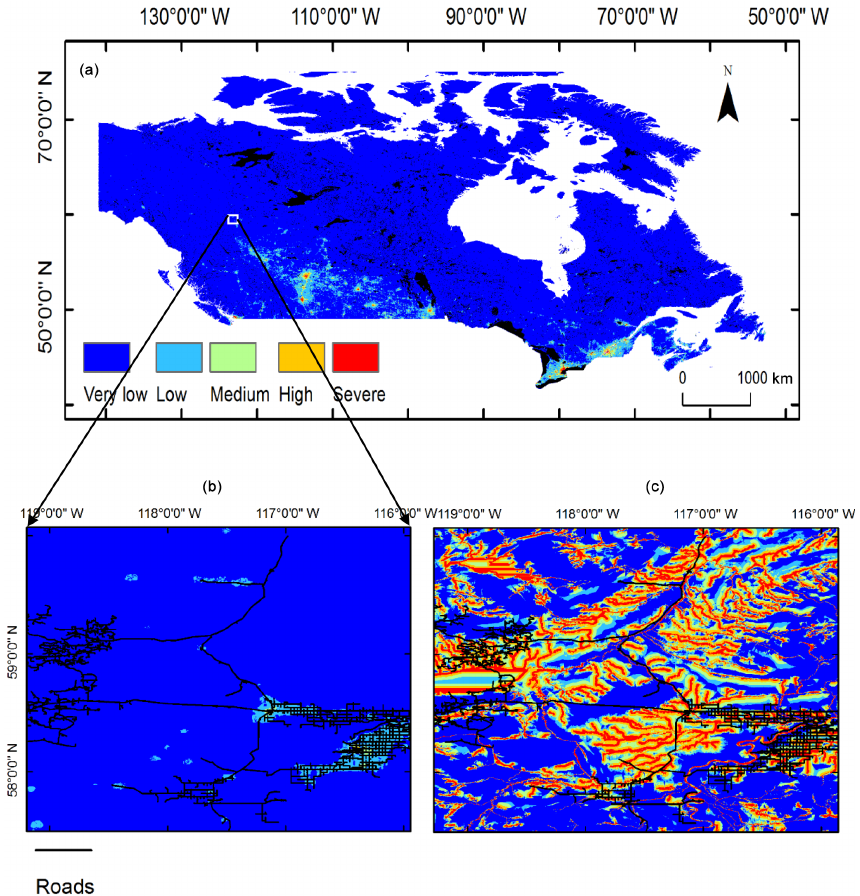
Figure 7. Classified flood exposure map for Canada. Severe and high exposure are concentrated around urban centres in the southern part of the country. Enlarged portion shows road network overlaid over (a) exposure map and (b) hazard